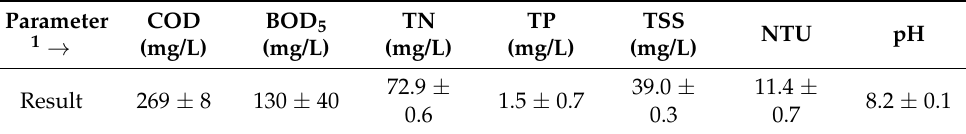
Table 1. Characterization of the wastewater before the treatment by the pilot-scale constructed wetland.